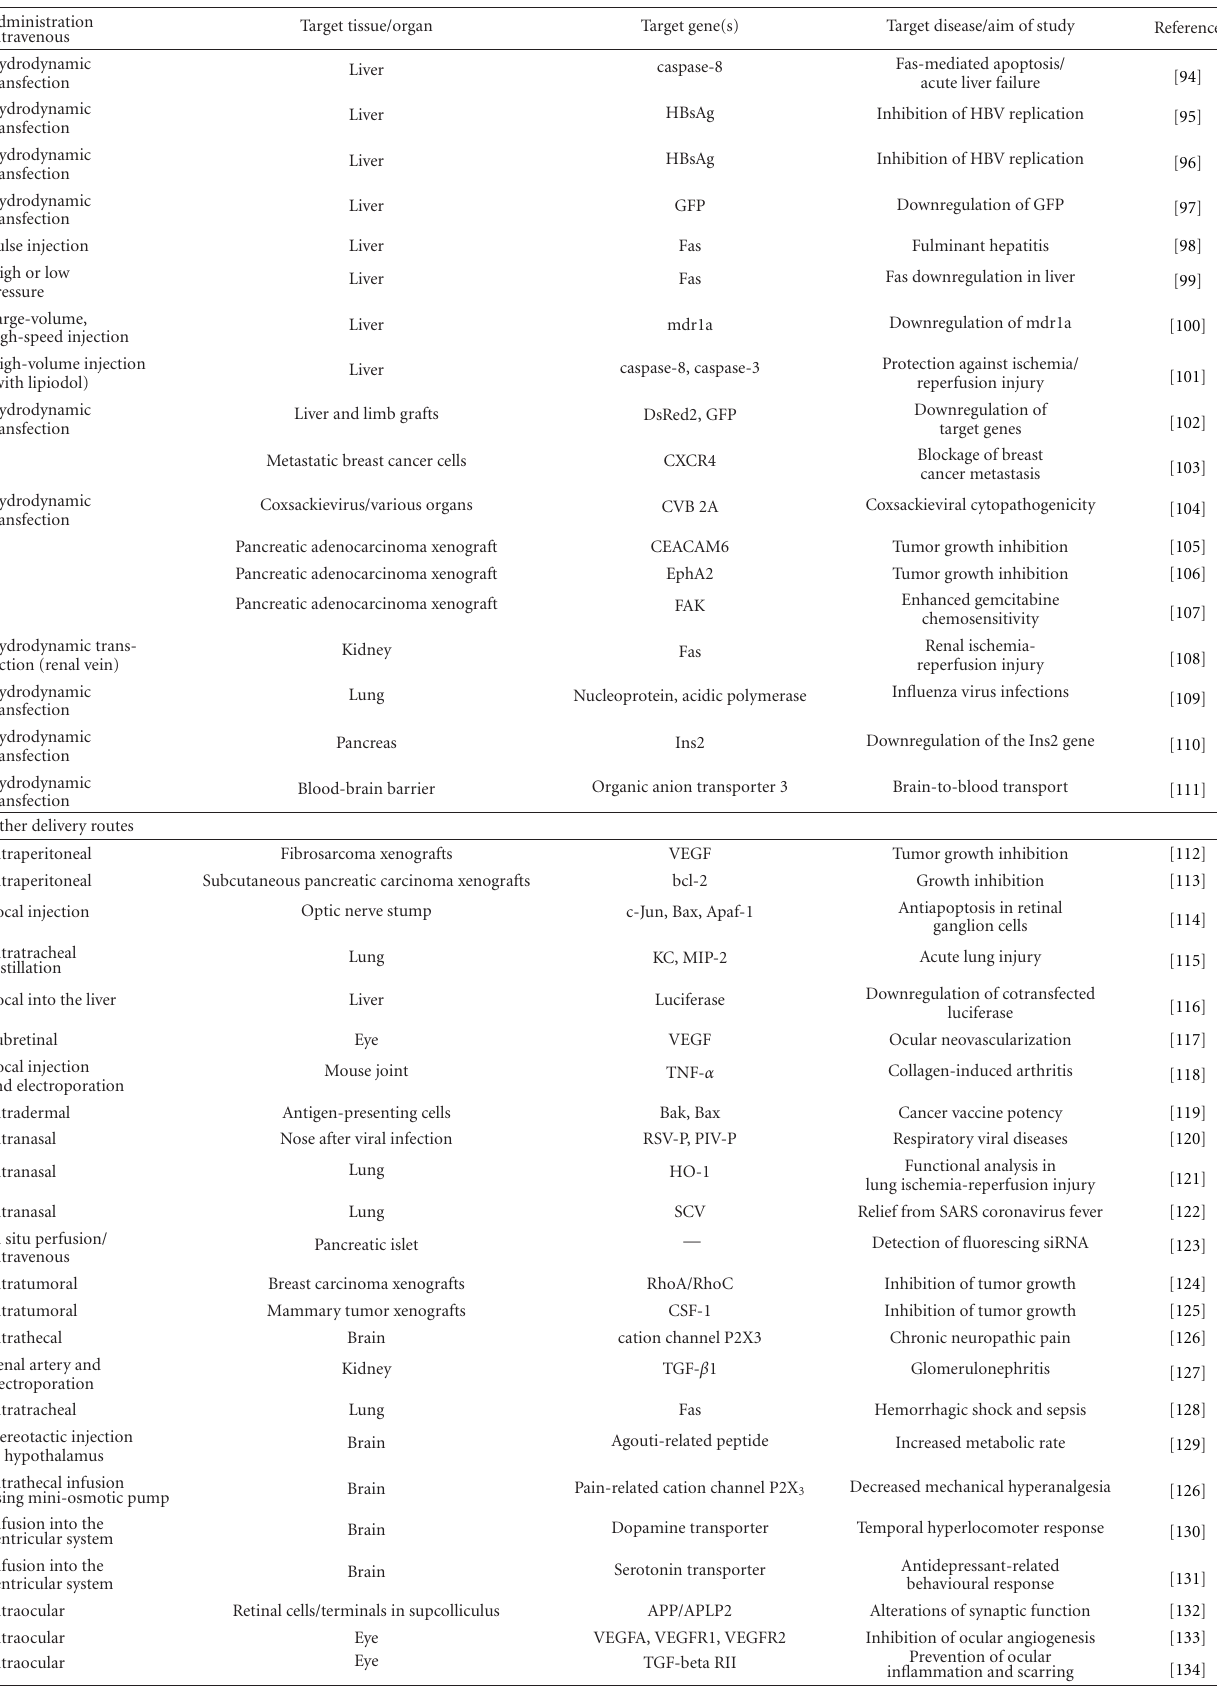
Table 1: Studies based on the direct application of siRNAs to induce RNAi in vivo: administration of unmodified